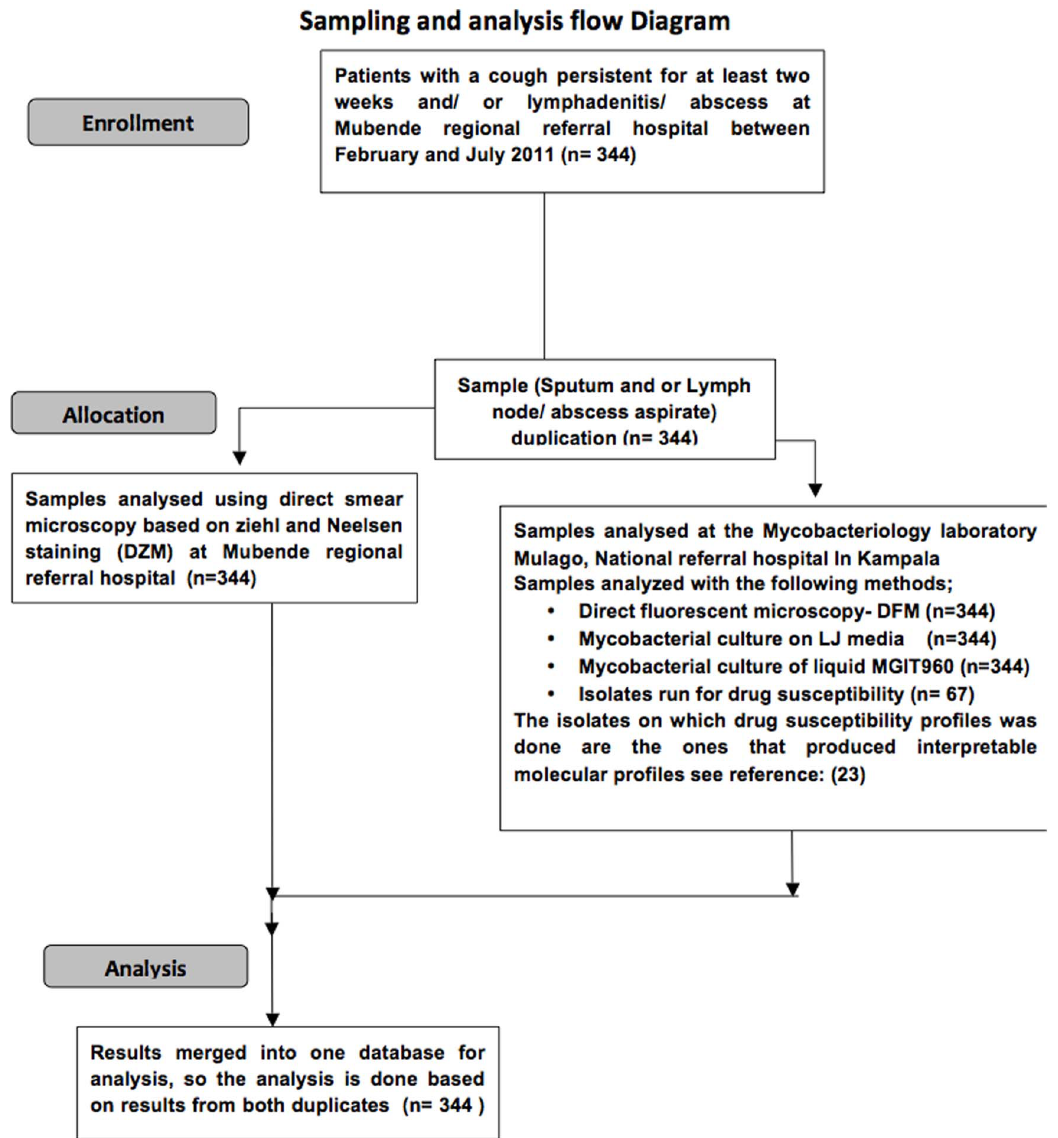
Figure 1. Sampling and sample analysis flow chat.